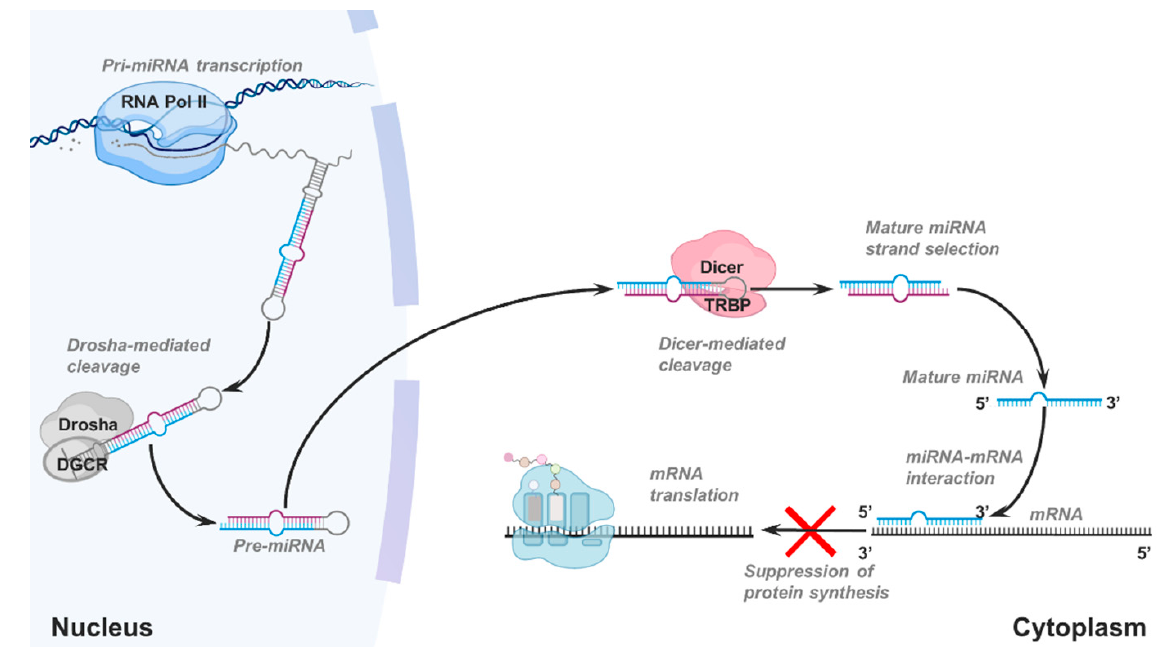
Figure 1. Illustration of canonical microRNA (miRNA) biogenesis. Once primary miRNA is transcribed, they are processed by the Drosha-DGCR8 complex and then exported to the cytoplasm. Here, pre-mRNA molecules are further processed by the Dicer-TRBP complex, usually generating two paired, partially complementary, mature miRNAs. One of the mature miRNA strands will be maintained while the other will be degraded. The selected miRNAs function as inhibitors of mRNA translation, usually by base-pairing of their seed region with complementary regions within the 3’ untranslated regions of the mRNAs.